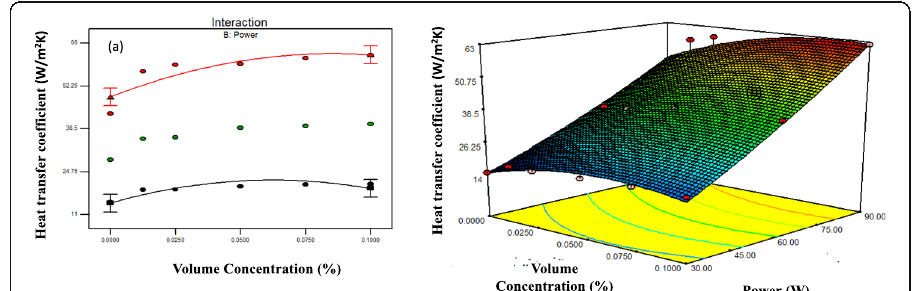
Fig. 11 a Interaction effect of heat transfer coefficient for hybrid nanofluid. b Response surface